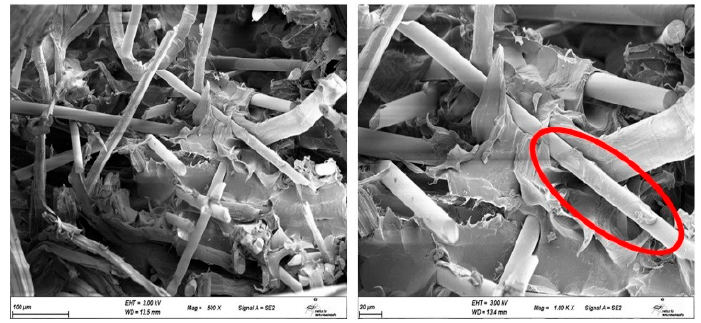
Figure 10. SEM analysis of tensile fracture surface of PP/25BA/KEFL composite showing matrix residue (marked) on BA fibers and stranded matrix between the fibers.